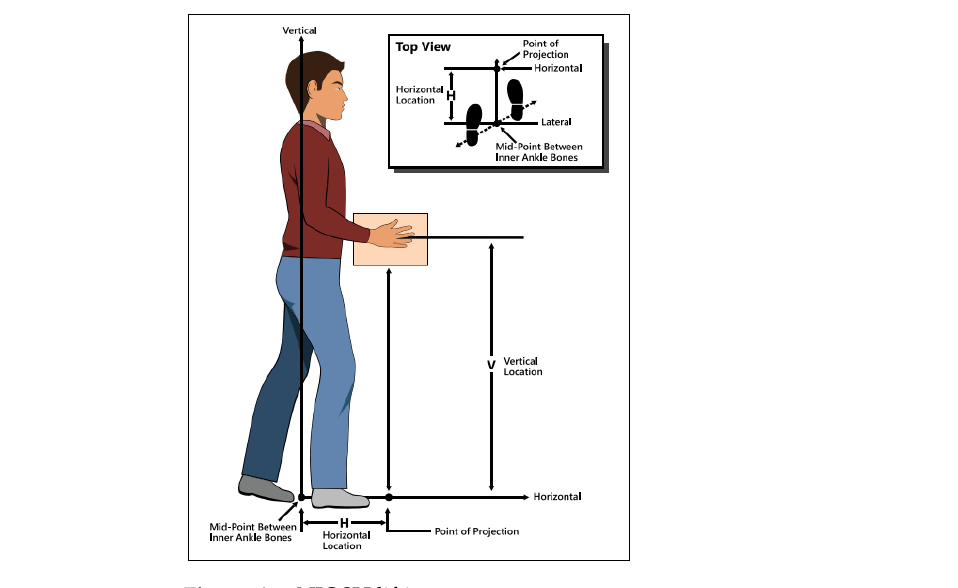
Figure A4. NIOSH lifting parameters.